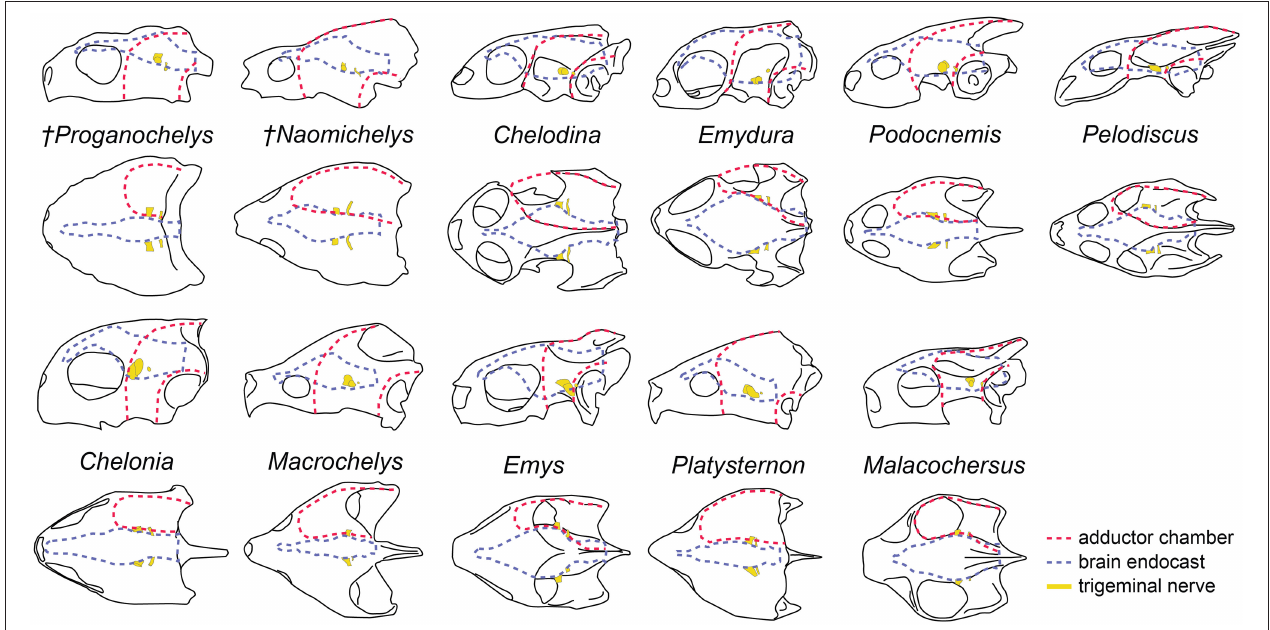
FIGURE 7 | Overall skull shape and relation to cranial structures in different turtle taxa. Brain endocast and adductor chamber plotted in left lateral (first and third rows) and dorsal (second and fourth rows) views. Note the similar position of the trigeminal nerve exit regardless of changes in surrounding